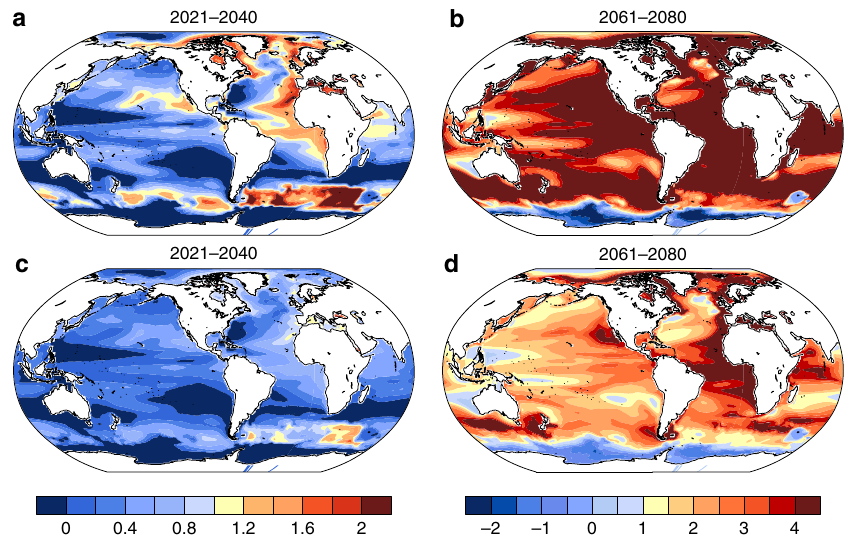
Fig. 5 Ratio of the sea level rise reduction and the standard deviation intra-ensemble members. a , b The quotient of the SLR reduction for RCP4.5 from RCP8.5 divided by one standard deviation (1 σ ) of the regional SLR within RCP8.5 ensemble for the period 2021 – 2040 and 2061 – 2080, respectively, which represents the 68% signi fi cance level if the quotient is >1. c , d The same as in a , b , but the SLR reduction is divided by 2 σ , which represents a 95% signi fi cance level if the quotient is >1. The left color bar is for a , c , and the right color bar is for b ,